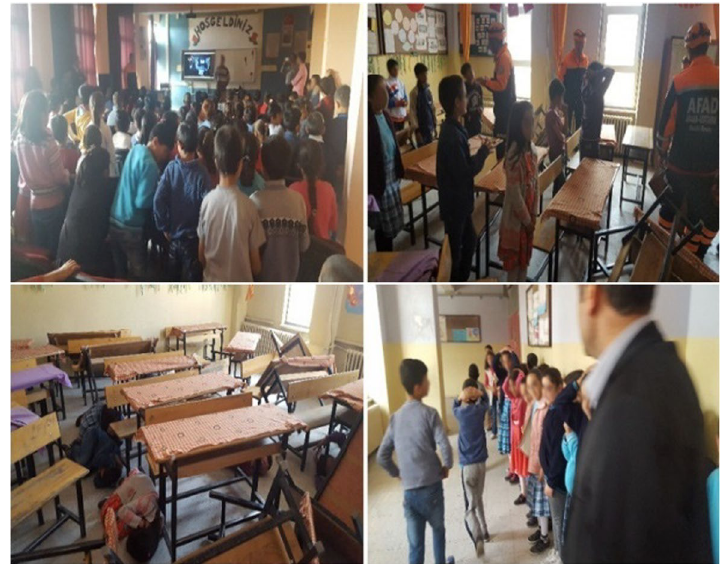
Fig. 4 Photographs from the process of practical